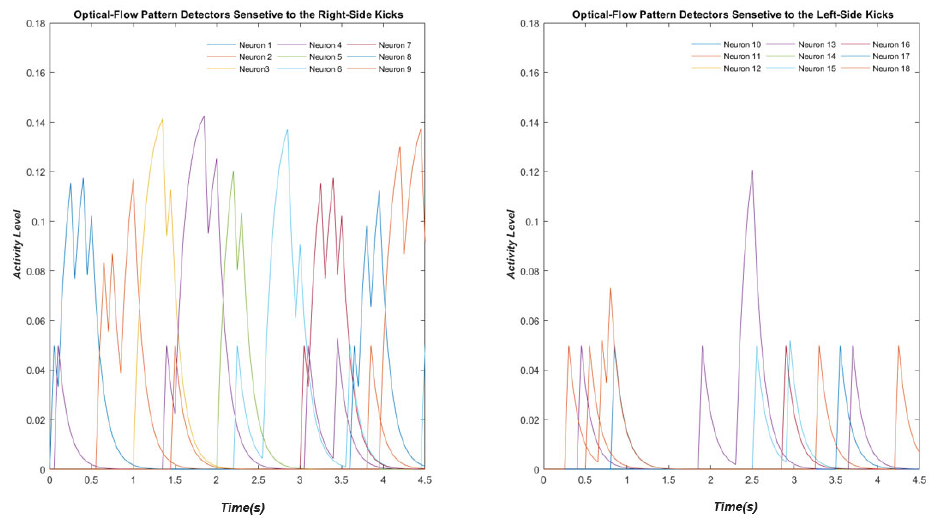
Figure 2. The activity of these neurons in the absence of the internal noise to the stimulus representing a kick with 9 ◦ of deviation to the right. Neurons 1 to 9 are responsive to the right-side kicks and neurons 11 to 18 are sensitive to the left-side kicks.